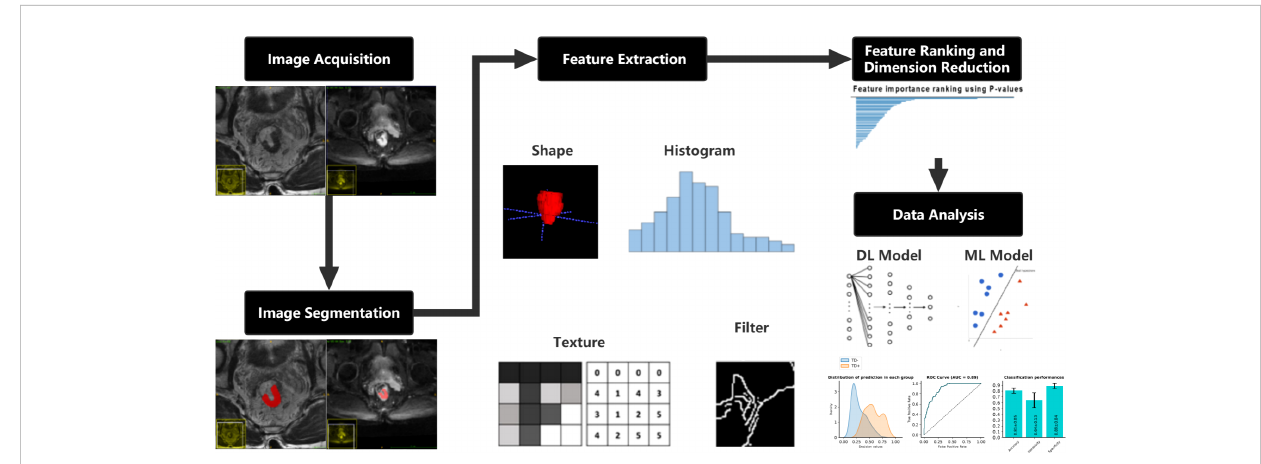
FIGURE 2 Flowchart describing the methods used in developing the clinical-DL radiomics model for TD prediction in patients with RC. DL, deep learning; TD, tumor deposition; RC, rectal cancer.